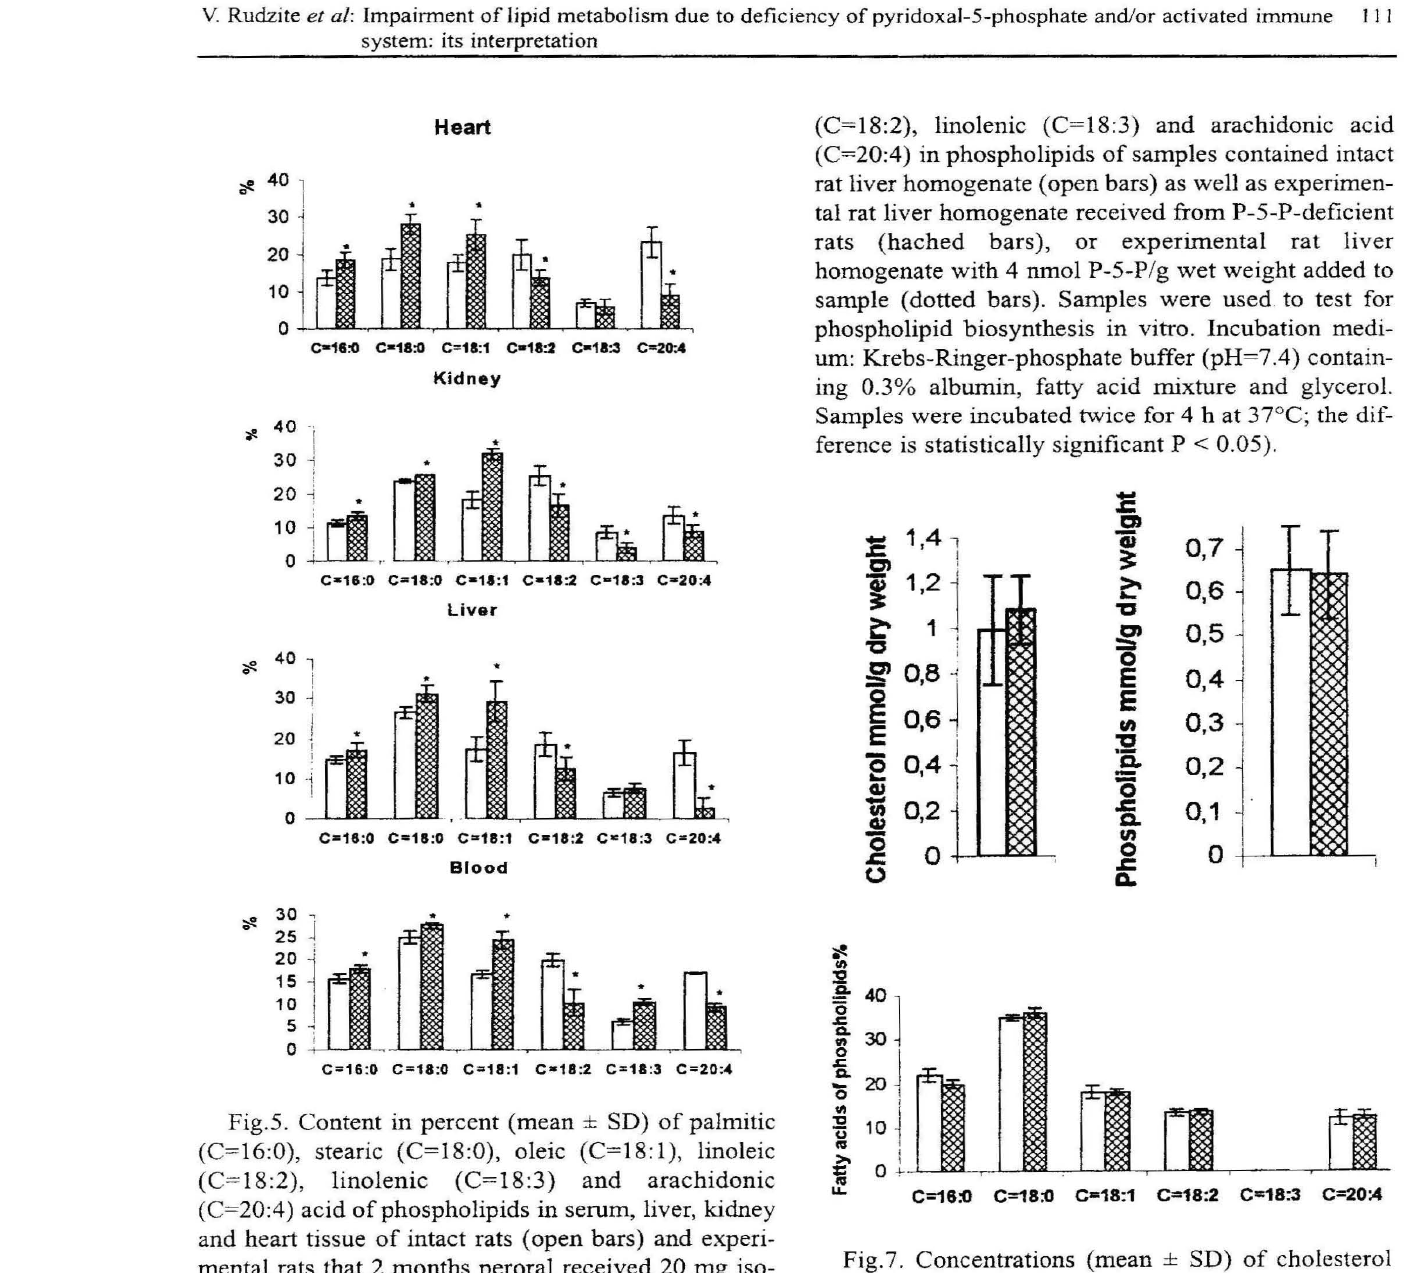
Fig.7. Concentrations (mean ± SD) of cholesterol and phospholipids as well as fatty acid content of phos pholipids in percent (mean ± SD) in control samples (open bars) and in samples with 4 nmo} P-S-P/g wet weight (dotted bars). Samples of rat liver tissue homogenate were used to test for phospholipid biosyn thesis in vitro. Incubation medium: Krebs-Ringer phosphate buffer (ph=7.4) containing 0.3% of albu min, fatty acid mixture and glycerol. Samples were incubated twice for 4 h at